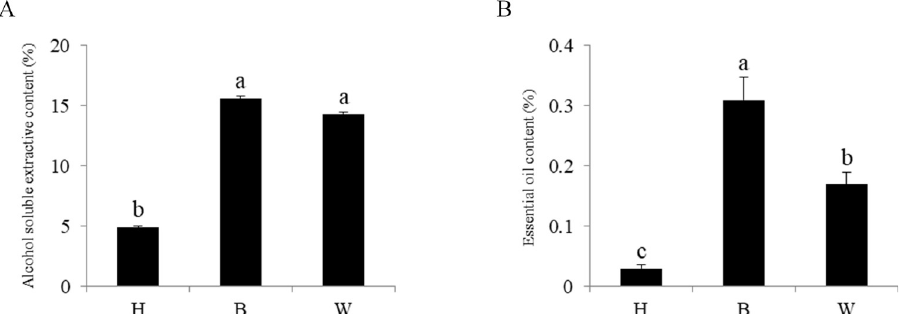
Fig 6. The contents of alcohol-soluble extractive and essential oils in the brown zone (B), wild agarwood (W), and healthy zone (H). (A) Alcohol soluble extractive content; (B) essential oil content.